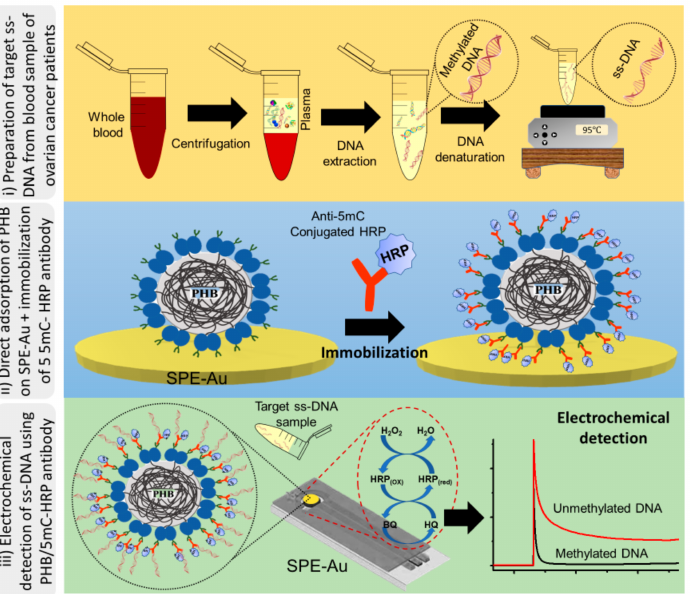
Figure 1. Schematic representation of DNA methylation assay using PHB nanobeads for modifying the electrode surface. Preparation of target ssDNA from blood samples of ovarian cancer patients ( top ) followed by direct immobilisation onto the surfaced bound 5mC/HRP-PHB complex. Direct adsorption of PHB onto SPE-Au and subsequent immobilisation of 5mC peroxidase conjugate ( middle ). The relative presence of methylated DNA is analysed by chronoamperometry in the presence of hydroquinone/H 2 O 2 redox system ( bottom ).